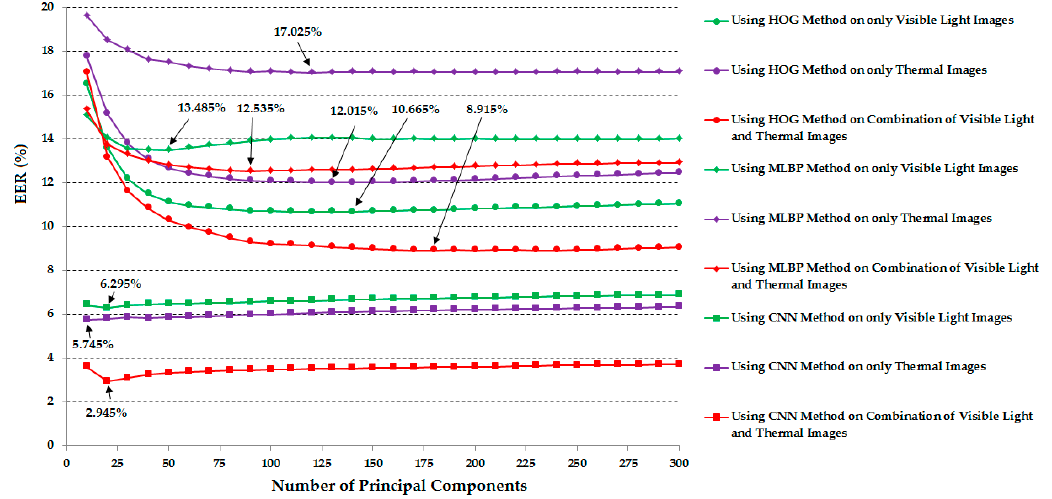
Figure 11. Verification accuracy (EER) of the recognition systems using Euclidean distance according to the number of principal components in PCA.